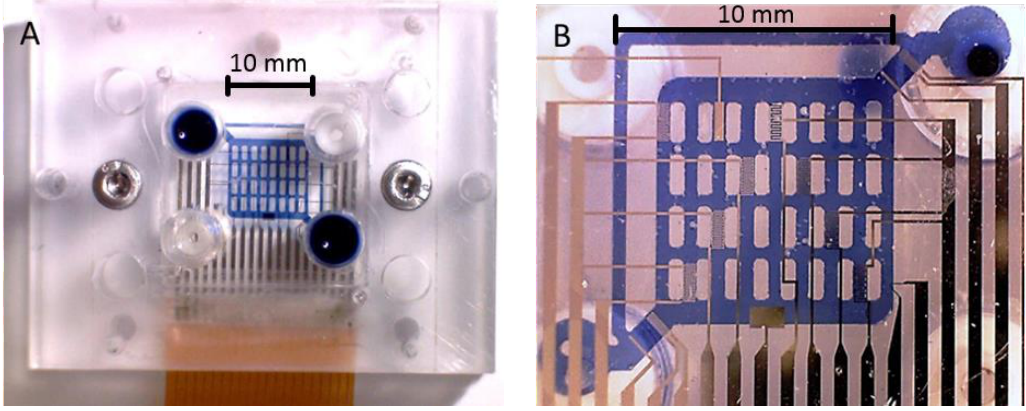
Figure 1. Image of the sensorized cell-culture system. For better visibility, the microfluidic channels were filled with trypan-blue solution; ( A ) Top view. Two screws (silver in color) were used to fix the glass chip with the Pt sensor and ETµP structures in between the PMMA cover and ground plates and to seal the PDMS channels. For the photo, two of the four 1/4 inch 28 microfluidic connectors (top right, bottom left) were sealed with PDMS plugs. The other two connectors (blue) were disconnected for the photo. Flexible circuit-board connector (bottom, brown) was soldered to the chip pads. ( B ) Bottom view through the assembled